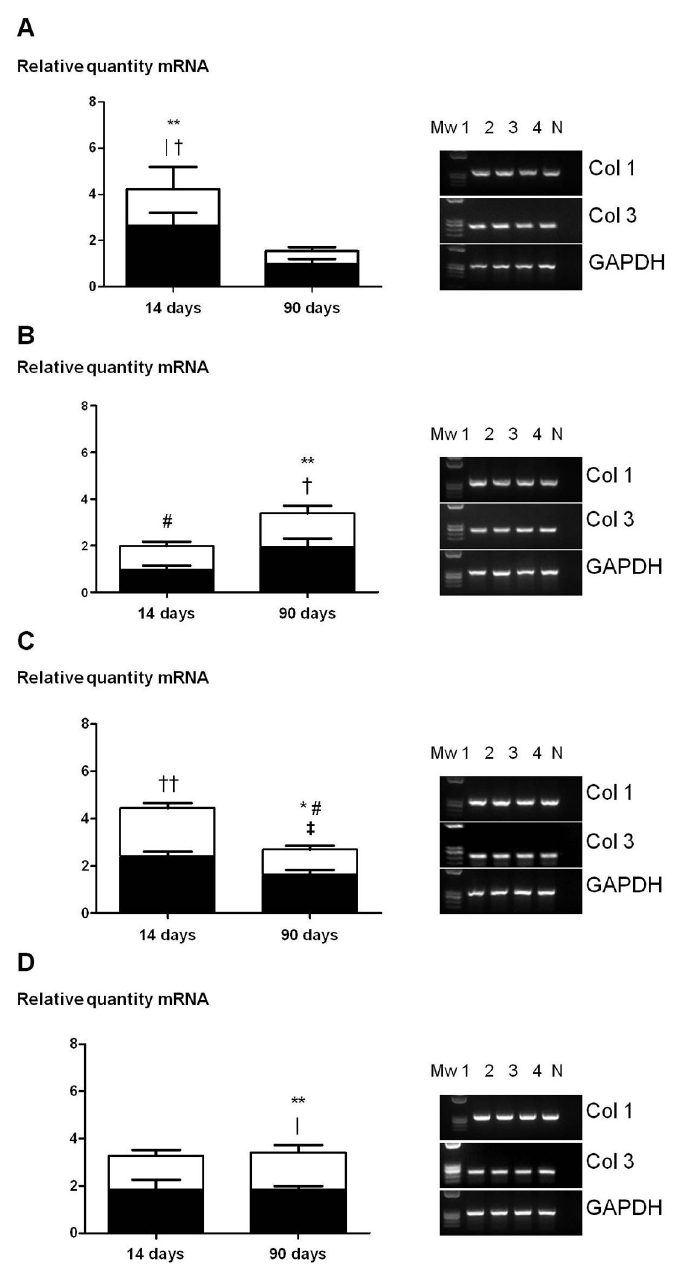
Figure 5. Collagen 1 and 3 mRNA expression determined by RT-PCR. Stacked bar charts of the relative mRNA amounts, collagen 1 (white bar) and 3 (black bar), recorded for Bard mesh TM (A), Physiomesh TM (B), the new composite mesh (C) and Ventralight TM (D) at the different study times (left panel). Results are the mean ± SEM of three experiments. Gene expression was normalized to that of the GAPDH gene. Agarose gels obtained (right panel). Mw: molecular weight markers; 1/2: 14 days postimplant; 3/4: 90 days postimplant; N: negative. Col 1: *, p<0.05 and **, p<0.01 vs. Bard TM at 90 days; #, p<0.01 vs. new composite mesh at 14 days. Col 3: |, p<0.05 vs. Bard TM at 90 days; †, p<0.05 and ††, p<0.01 vs. Physiomesh TM at 14 days; ‡, p<0.05 vs. new composite mesh at 14 days.